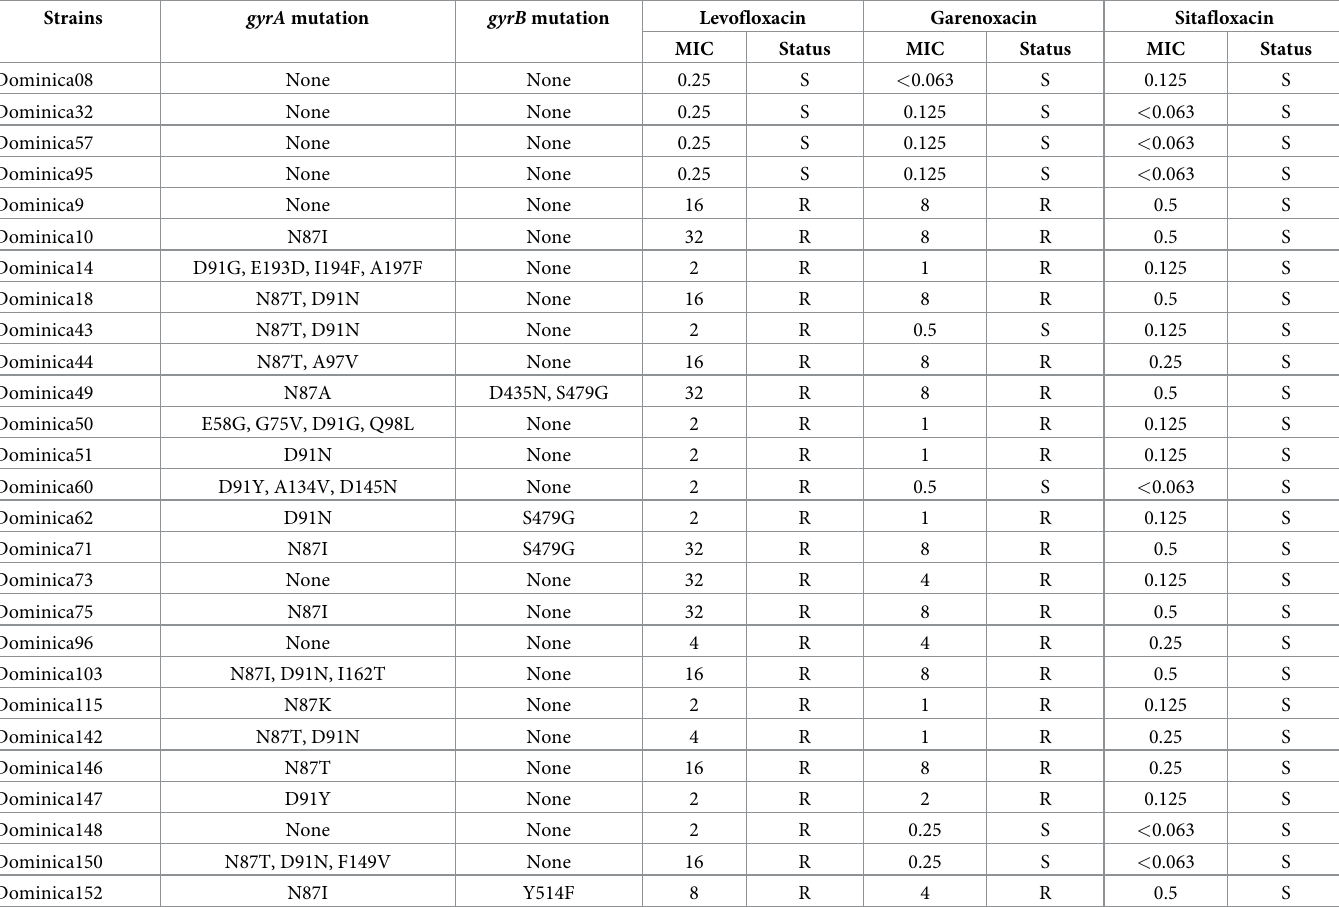
Table 4. Levofloxacin, garenoxacin, sitafloxacin and with gyrA and gyrB mutations. Strains gyrA